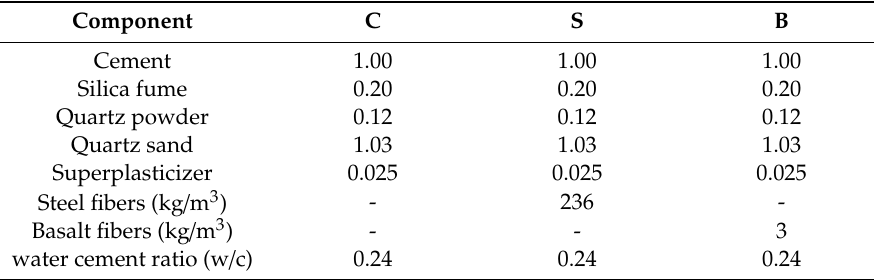
Table 2. Composition of RPC mixes (proportion to cement).